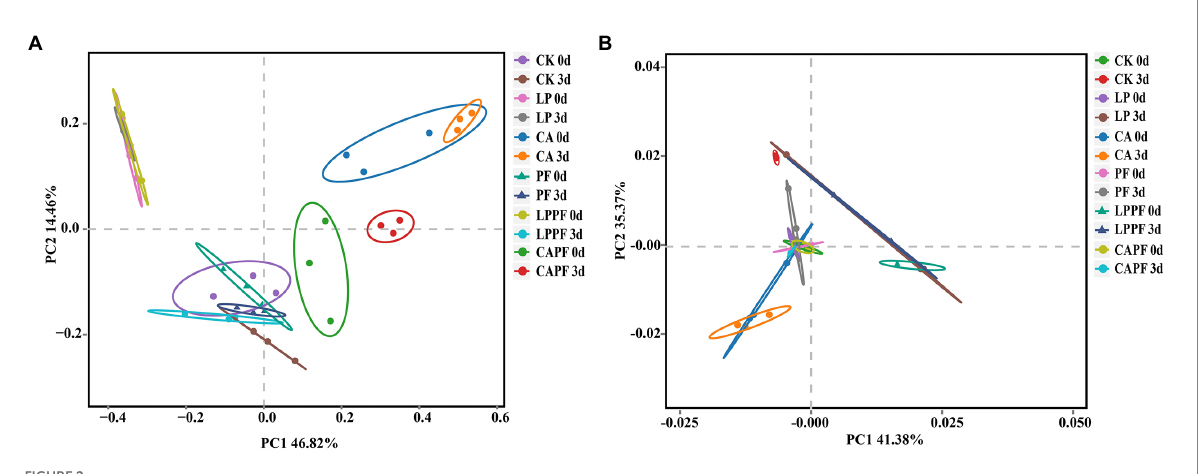
FIGURE 2 Principal component analysis of the bacterial (A) , and fungal community (B) , of forage oat silages. CK, control; LP, Lactobacillus plantarum a 214; CA, citric acid; PF, purple perilla; LPPF, purple perilla + Lactobacillus plantarum a214; CAPF, purple perilla + citric acid; 0d, 60-day of ensiling; 3 d, 3 days of aerobic